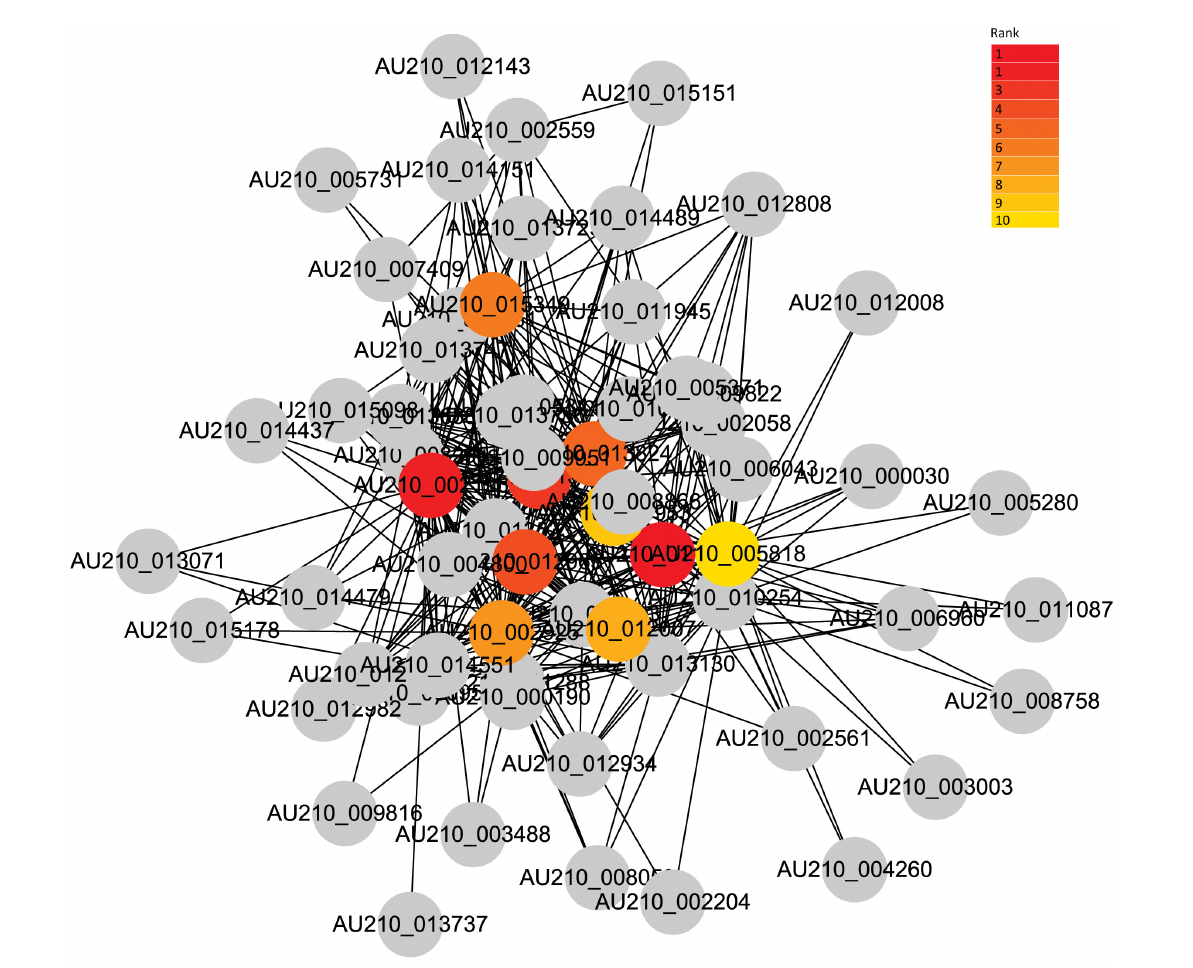
FIGURE6 Co-expression network analysis of the turquoise module. The red to yellow circle represent the hub gene identified by cytoHubba in Cytoscape, and the color shade indicates the